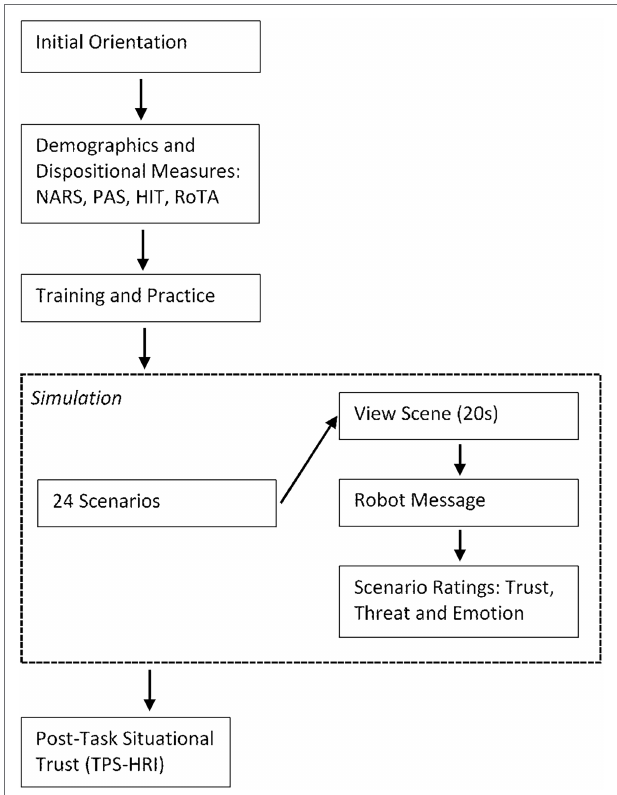
FIGURE 2 | Summary of the